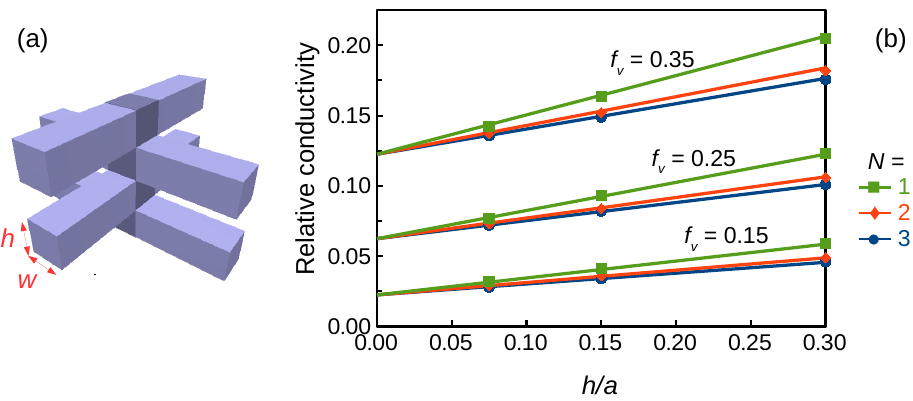
Figure A1. ( a ) Unit cell of the woodpile structure composed of N = 2 layers ( w / a = 0.15, h / a = 0.15). The part in deep color represents the core column. ( b ) Plot of κ e / κ m versus the height to length ratio h / a of the bars for three volume-filling fractions f v = w / a and for N = 1, 2, and 3 layers. The symbols are from Table 1 and the full lines are from Equation